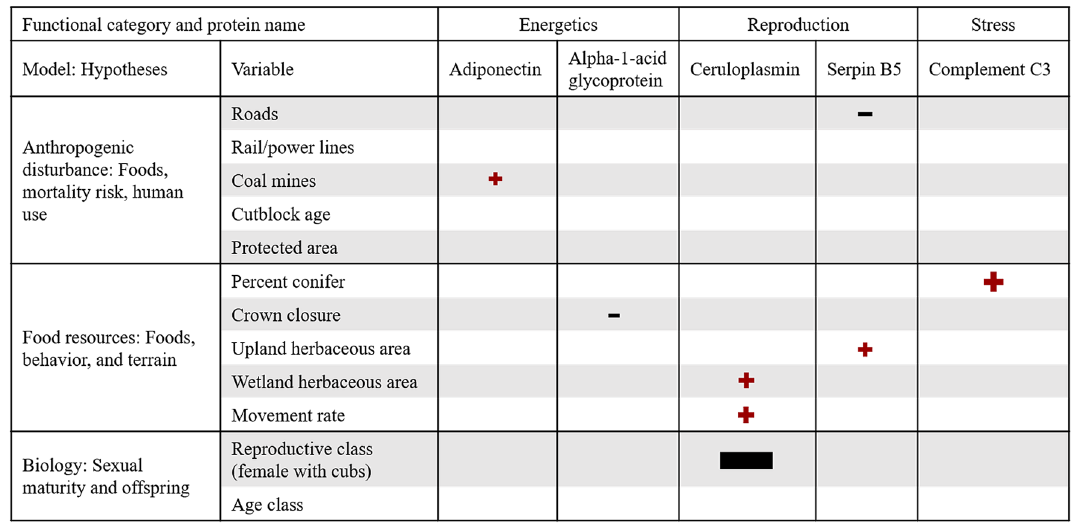
Figure 1. Standardized coefficients represented by symbols for the significant (95% confidence interval does not include zero) parameters in the minimum adequate models (model selection by AICc < 2) with corresponding hypotheses for predicting protein expression in skin samples collected from grizzly bears across Alberta, Canada. The shape and color of each symbol indicates the relationship (red positive sign = direct and grey negative sign = inverse) and the size of each symbol indicates the magnitude of the coefficient